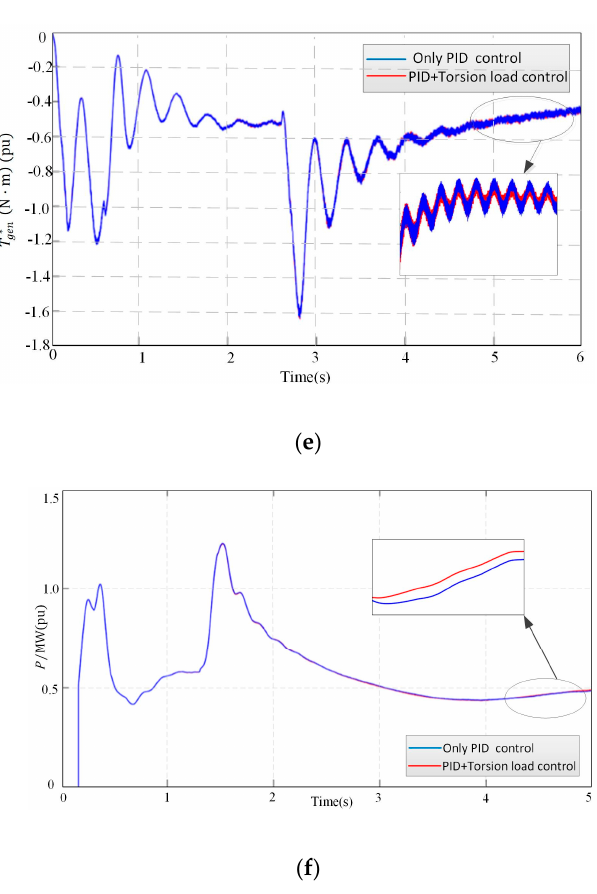
Figure 9. Simulation results under constant wind speed (16 m/s). ( a ) Wind speed ( ω t )16 m/s ; ( b ) Output mechanical torque on the shaft ( T shaft ); ( c ) Torsion vibration angle ( θ s ); ( d ) Electromagnetic torque reference value ( T e * ); ( e ) The given value of the electromagnetic torque ( T ∗ gen ) ; ( f ) Active power ( p ).